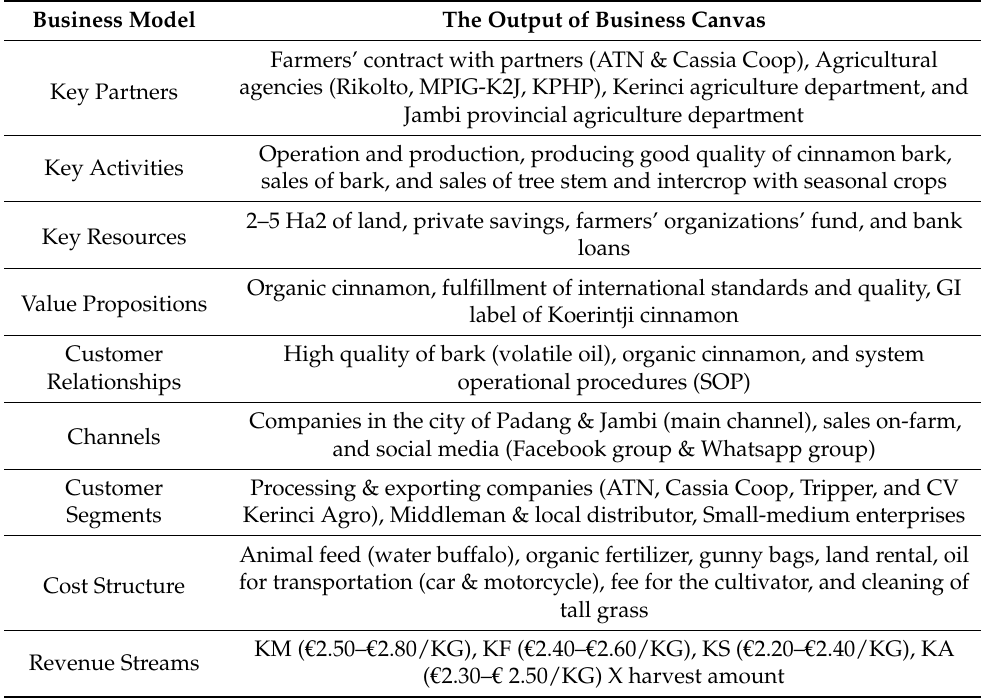
Table 2. The business model canvas of cinnamon in